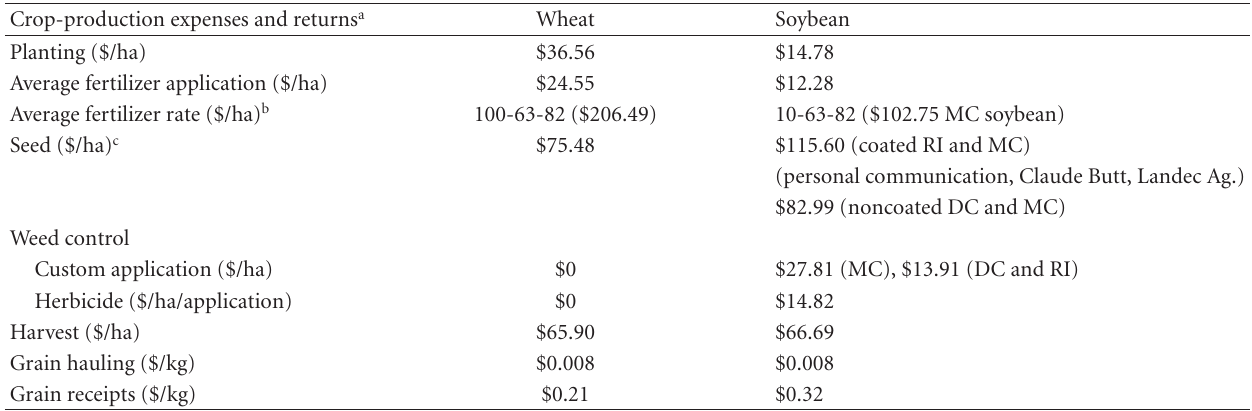
Table 2: Custom crop-production expenses [32] and returns [33, 34] used to calculate gross margins.